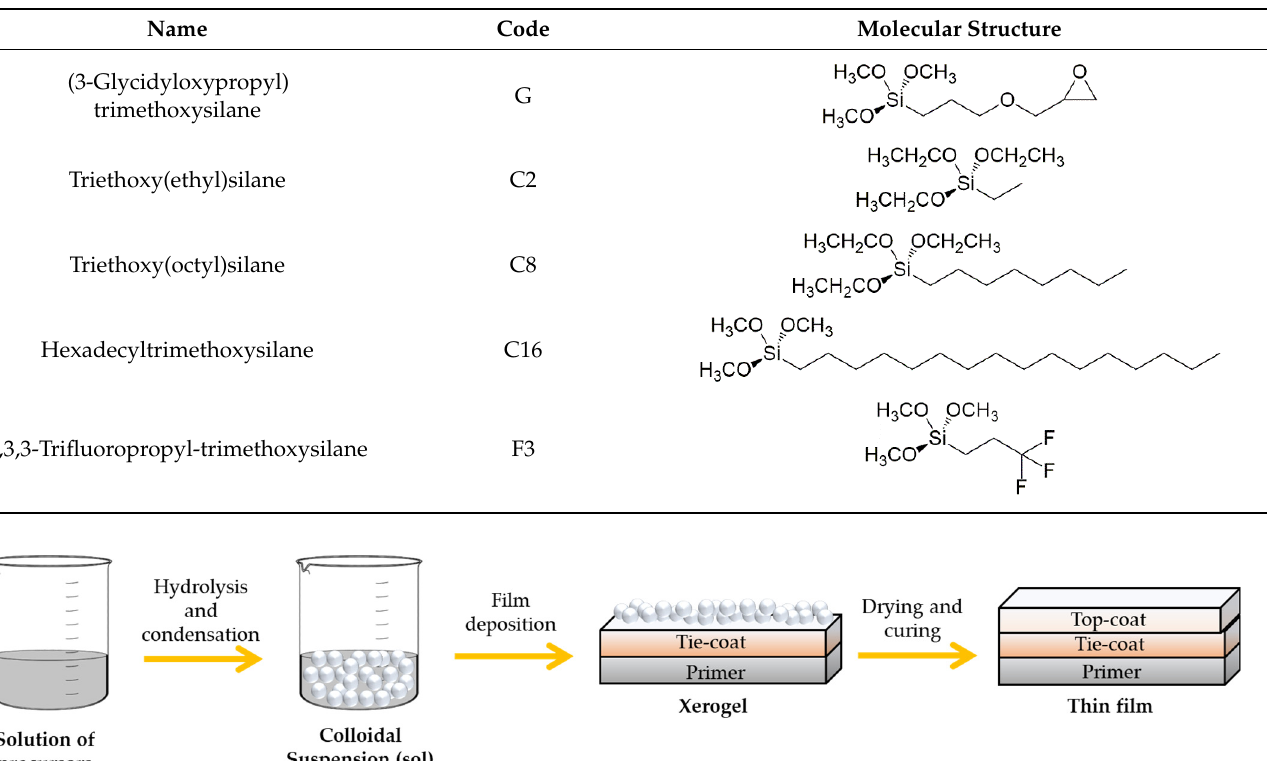
Table 1. Sol-gel alkoxysilane precursors.